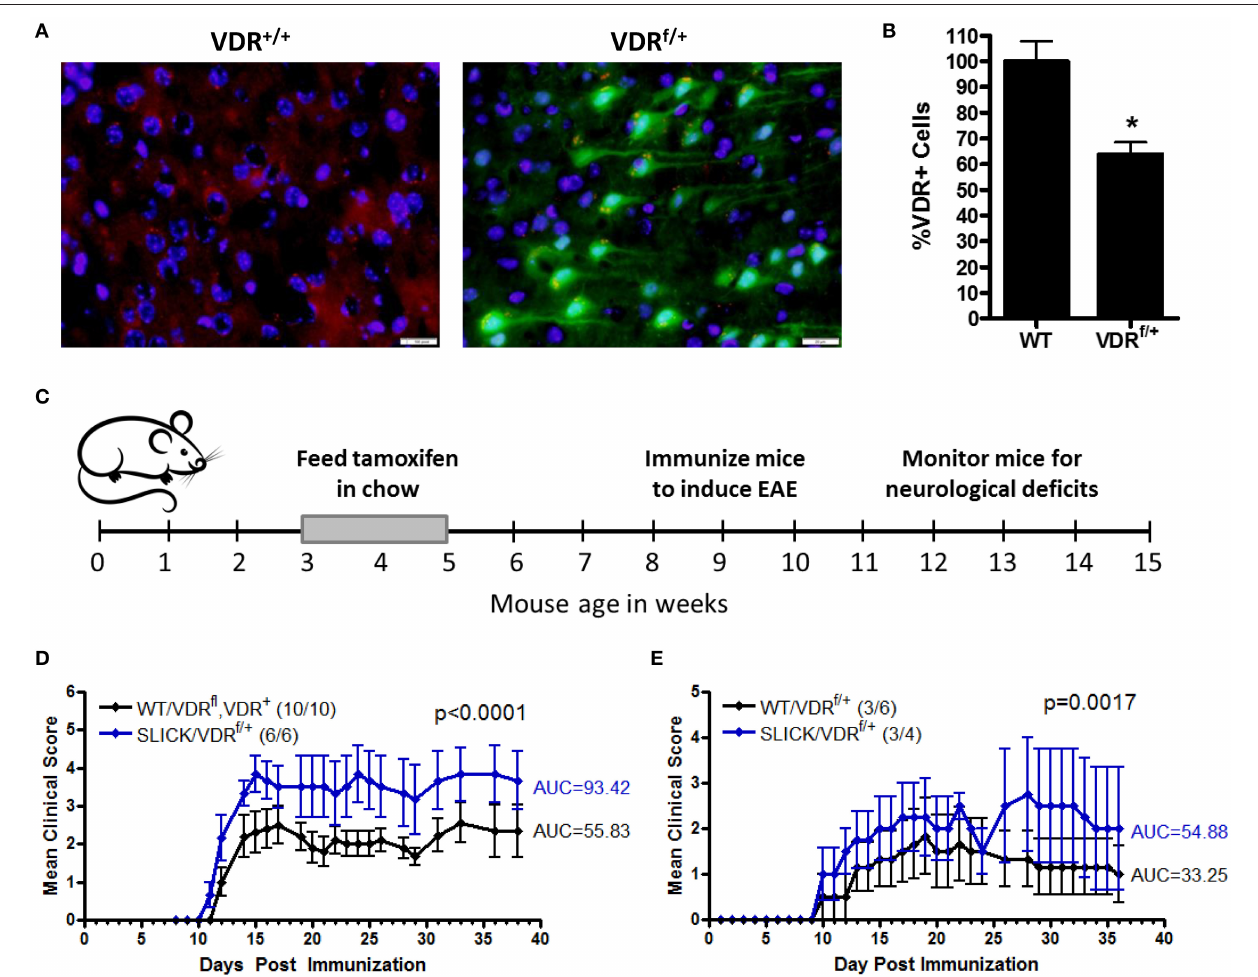
FIGURE 4 | Reduced VDR signaling in neurons during early life enhances CNS autoimmunity. VDR f / + mice were crossed with SLICK-H [Tg(Thy1-cre/ ERT2,-EYFP)HGfng/PyngJ] to generate SLICK/VDR f / + mice. Experiments used littermates and all mice were fed tamoxifen chow from 3 to 5 weeks of age and then returned to standard chow. (A) The brains and spinal cords were analyzed for VDR expression—red = VDR, green = Cre-EYFP, blue = DAPI. (B) Quantification of VDR + cells in the brain and spinal cord, normalized to WT mice. N = 7 per group, * p < 0.05. (C,D) Mice were fed tamoxifen chow at 3–5 weeks and immunized at 8–10 weeks with 50 µ g MOG35-55 and 50 µ g PLP139-151 homogenized in CFA containing 2 mg/ml Mycobacterium tuberculosis , followed by an i.p. injection with pertussis toxin (100 ng/mouse). Controls = 10 and SLICK/VDR f / + = 6 mice. p < 0.0001 for EAE scores (Mann-Whitney). (E) Mice were fed tamoxifen chow at 3–5 weeks and immunized at 8–10 weeks with 12 µ g MOG35-55 and 12 µ g PLP139-151 homogenized in CFA containing 1 mg/ml Mycobacterium tuberculosis , followed by an i.p. injection with pertussis toxin (25 ng/mouse). Controls = 6 and SLICK/VDR f / + = 4 mice. p < 0.0017 for EAE scores (Mann-Whitney). Data is representative of ≥ 3